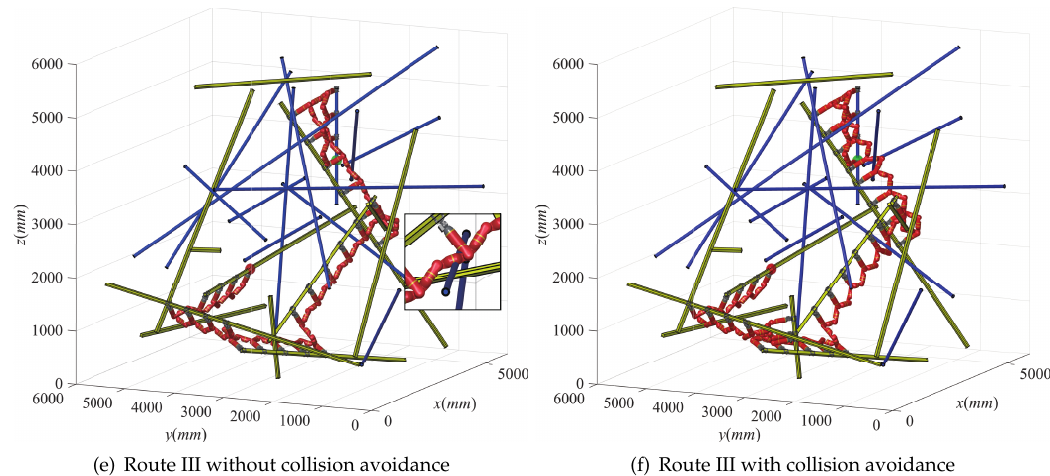
Figure 14. Comparison of results of grip planning with and without consideration of collision avoidance in a scene of 25